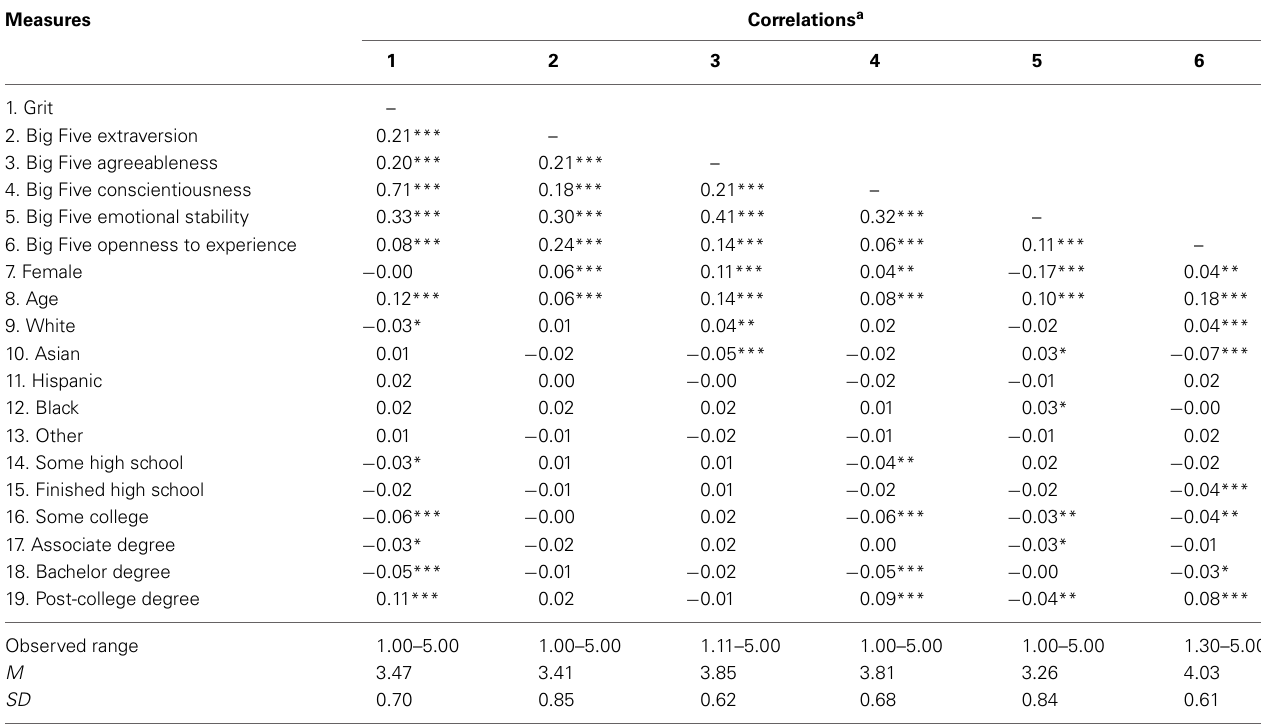
Table 4A | Summary Statistics and Intercorrelations for Married and Divorced participants (Study 4).